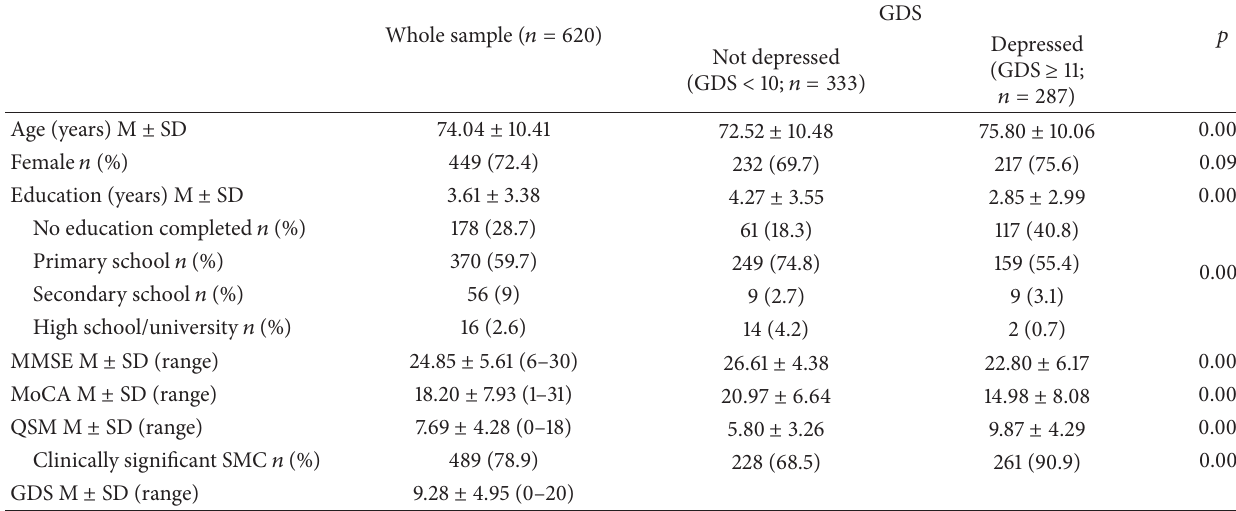
Table 1: Demographics and test scores of the study groups.